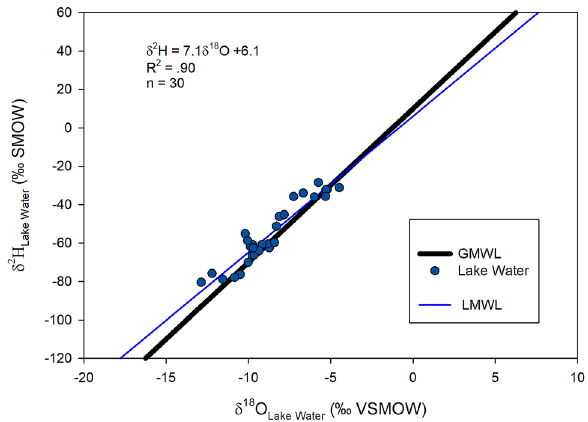
Figure 2. The GMWL (black line) and lake water δ 2 H and δ 18 O values plotted (blue circles) and the resulting LMWL (blue). Data represent averages of multiple measurements taking in different sampling years (up to n = 3) where